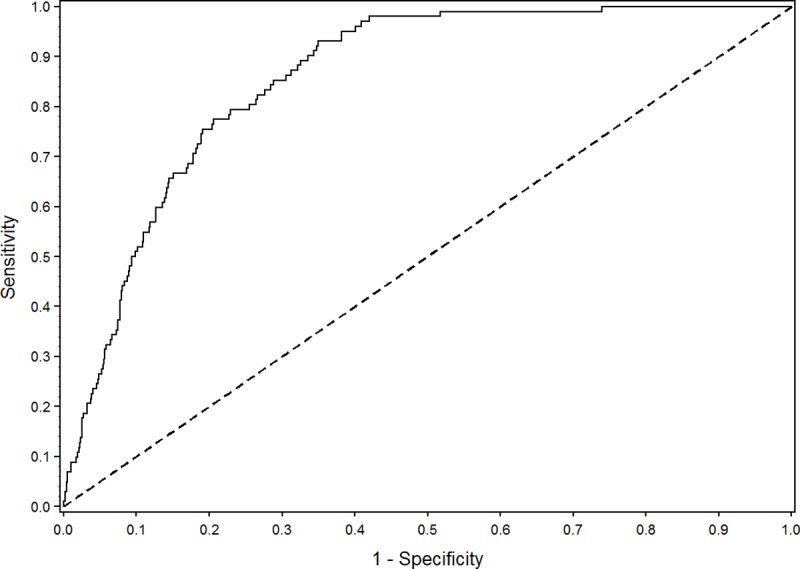
The ROC curve of the model.